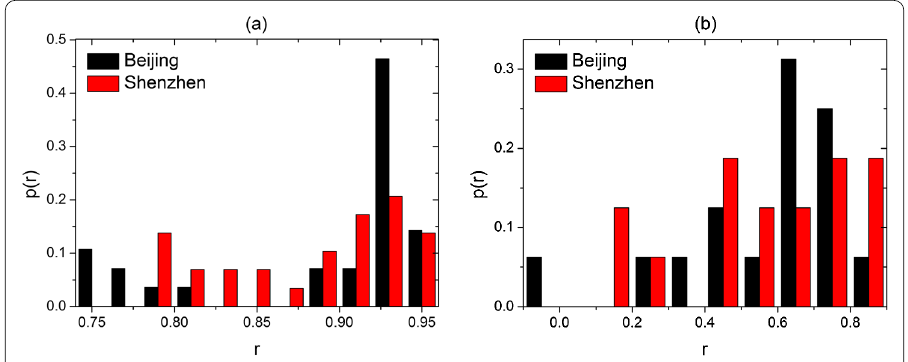
Figure 4 The distribution of Pearson correlation coefficient of q r c and CDI r . (a) The distribution of Pearson correlation coefficient of q r c and CDI r for the whole day. (b) The distribution of Pearson correlation coefficient of q r c and CDI r during morning peak. (a) contains indices of all days in October, while (b) only involves indices in workdays in